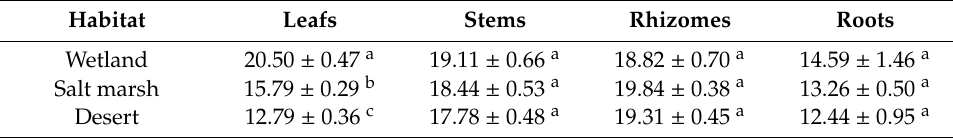
Table 1. Comparison of NSC content in clonal modules of Phragmites communis in different habitats.